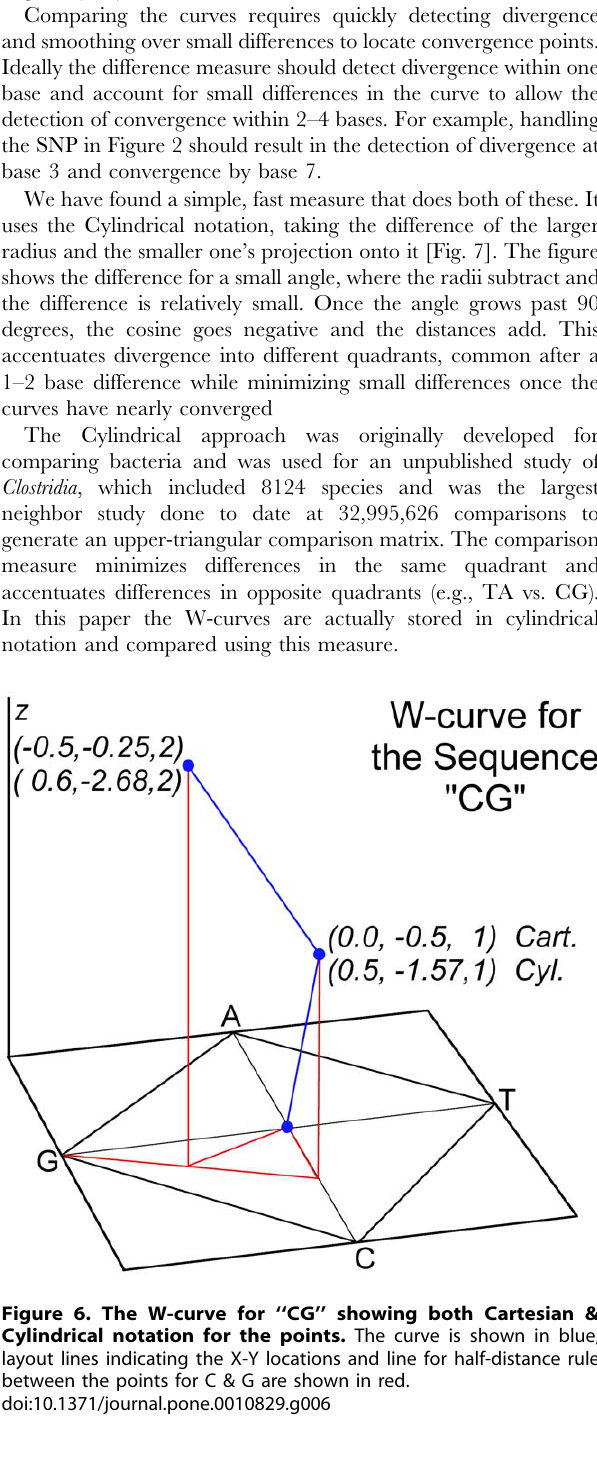
Figure 5. W-curve Z-Axis view of complete HIV-1 Genome showing all points (A), points near origin with radius , .5 (B) and further out, with radius . .5 (C). The last group of points (C) is used to re-align the curves after a gap. CG dinucleotide deficiencies are seen in B and C.